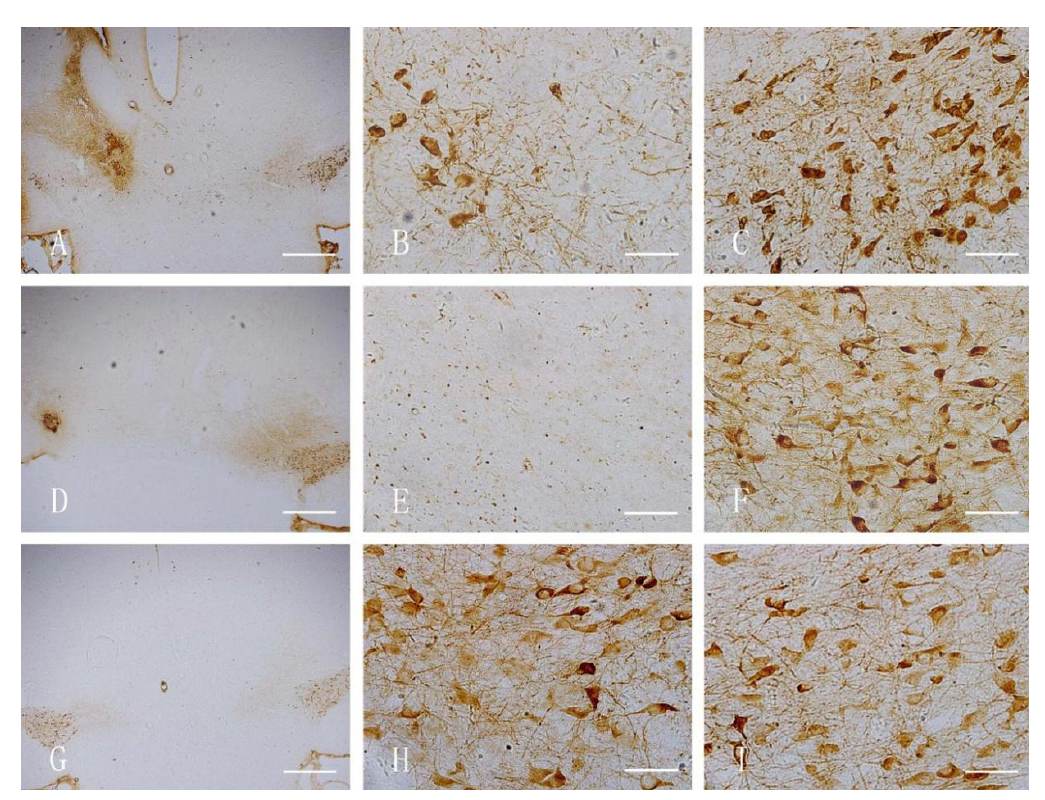
Figure 1. TH immunohistochemical staining of rat midbrain. ( A ) Damaged side of nano-MnO group (40×), Bar = 500 μm; ( B ) damaged side of nano-MnO group (400×), 2 2 Bar = 50 μm; ( C ) uninjured side of nano-MnO group (400×), Bar = 50 μm; ( D ) damaged 2 side of 6-OHDA group (40×), Bar = 500 μm; ( E ) damaged side of 6-OHDA group (400×), Bar = 50 μm; ( F ) uninjured side of 6-OHDA group (400×), Bar = 50 μm; ( G ) damaged side of saline group (40×), Bar = 500 μm; H: damaged side of saline group (400×), Bar = 50 μm; and I: uninjured side of saline group (400×), Bar = 50